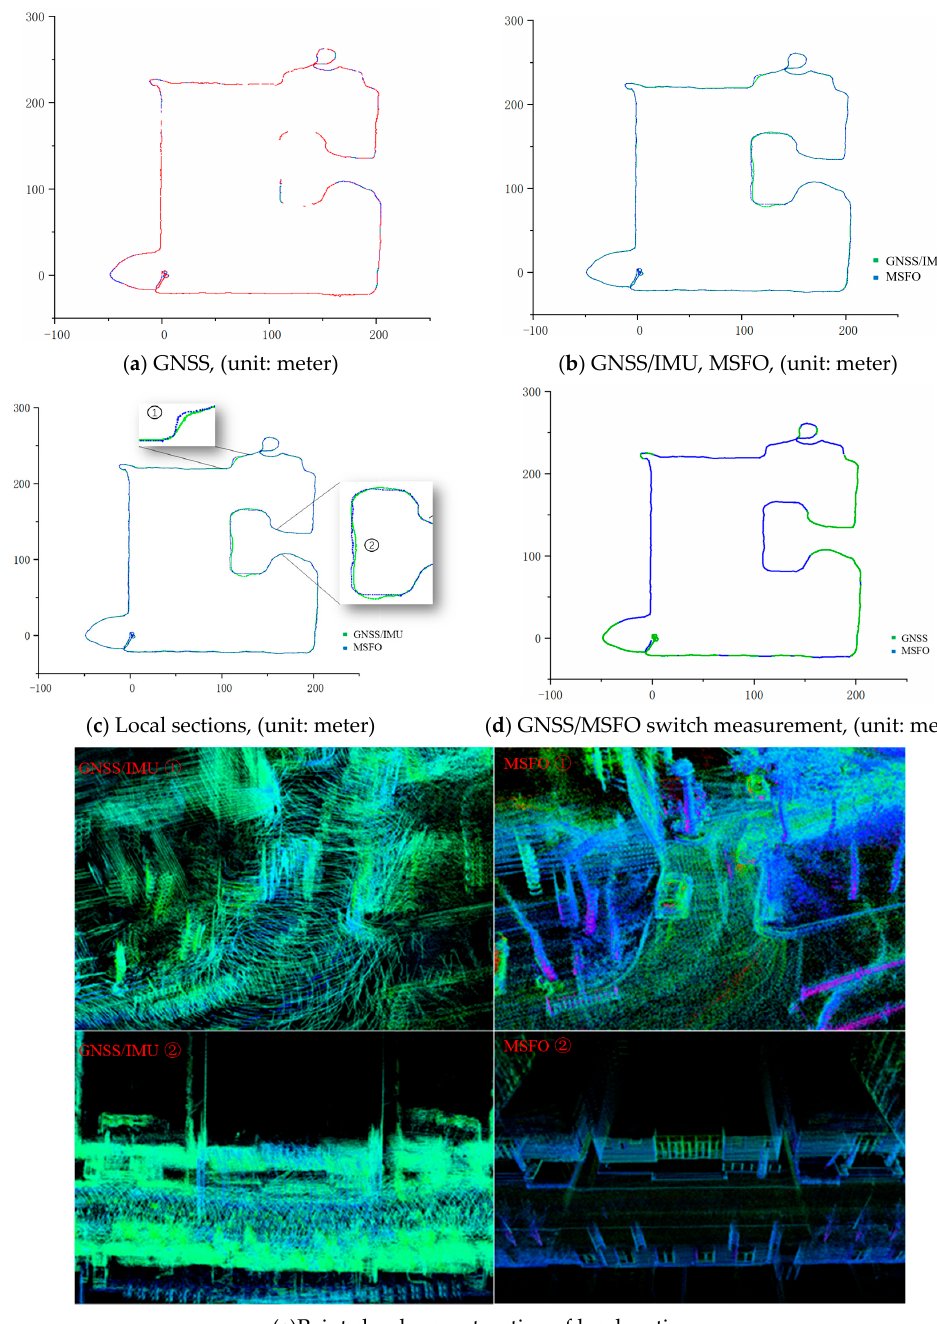
Figure 12. GNSS, GNSS/IMU, MSFO, the alternate update amount, and the point cloud reconstruc- tion of local sections. There is good scene complementarity between GNSS and MSFO. The SO switches measurements between GNSS and SLAM odometry to get the preferred measurement, as shown in ( d